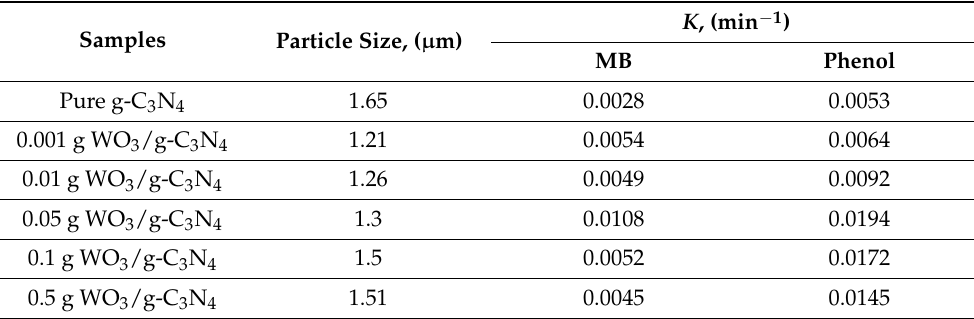
Table 2. Particle size and corresponding rate constants of pure g-C 3 N 4 and its WO 3 /g-C 3 N 4, with various amounts of tungsten oxide (0.001, 0.01, 0.05, 0.1, and 0.5% WO 3 ).